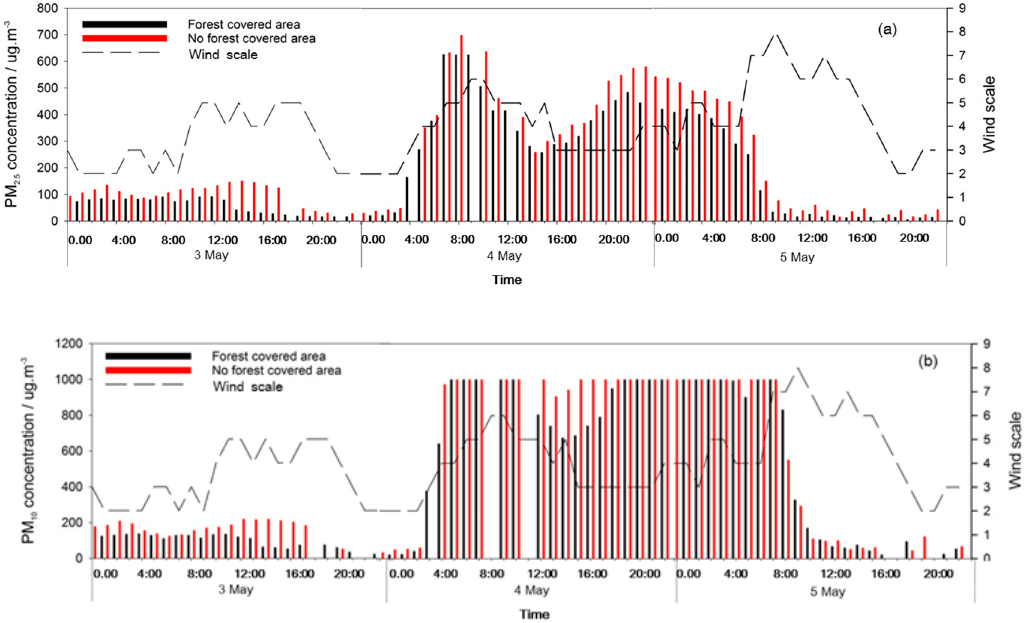
Figure 6. PM 2.5 ( a ) and PM 10 ( b ) concentrations changes during dust storm.